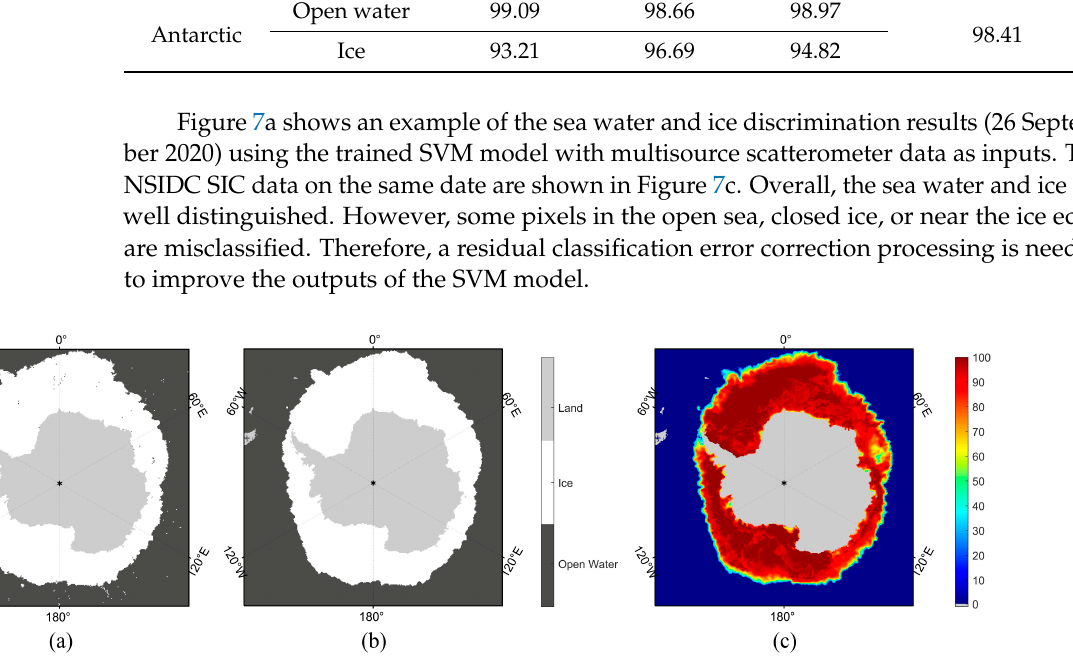
Figure 6. Time series of model performance in the Antarctic for the period from 2019 to 2021: ( a ) overall accuracy; and precision, recall and F1 scores for ( b ) open water and ( c ) sea ice.